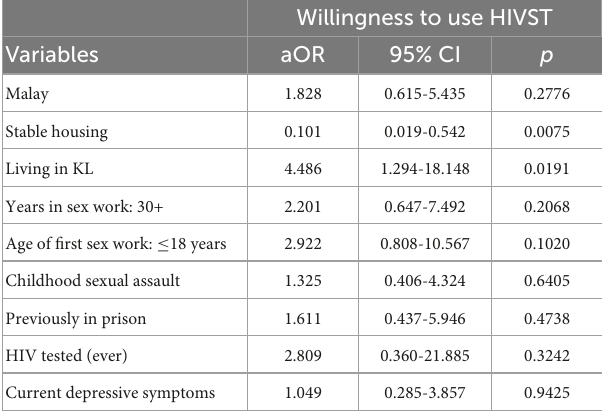
TABLE 2 Multivariate logistic regression analysis of factors associated with willingness to use HIV self-testing ( N =